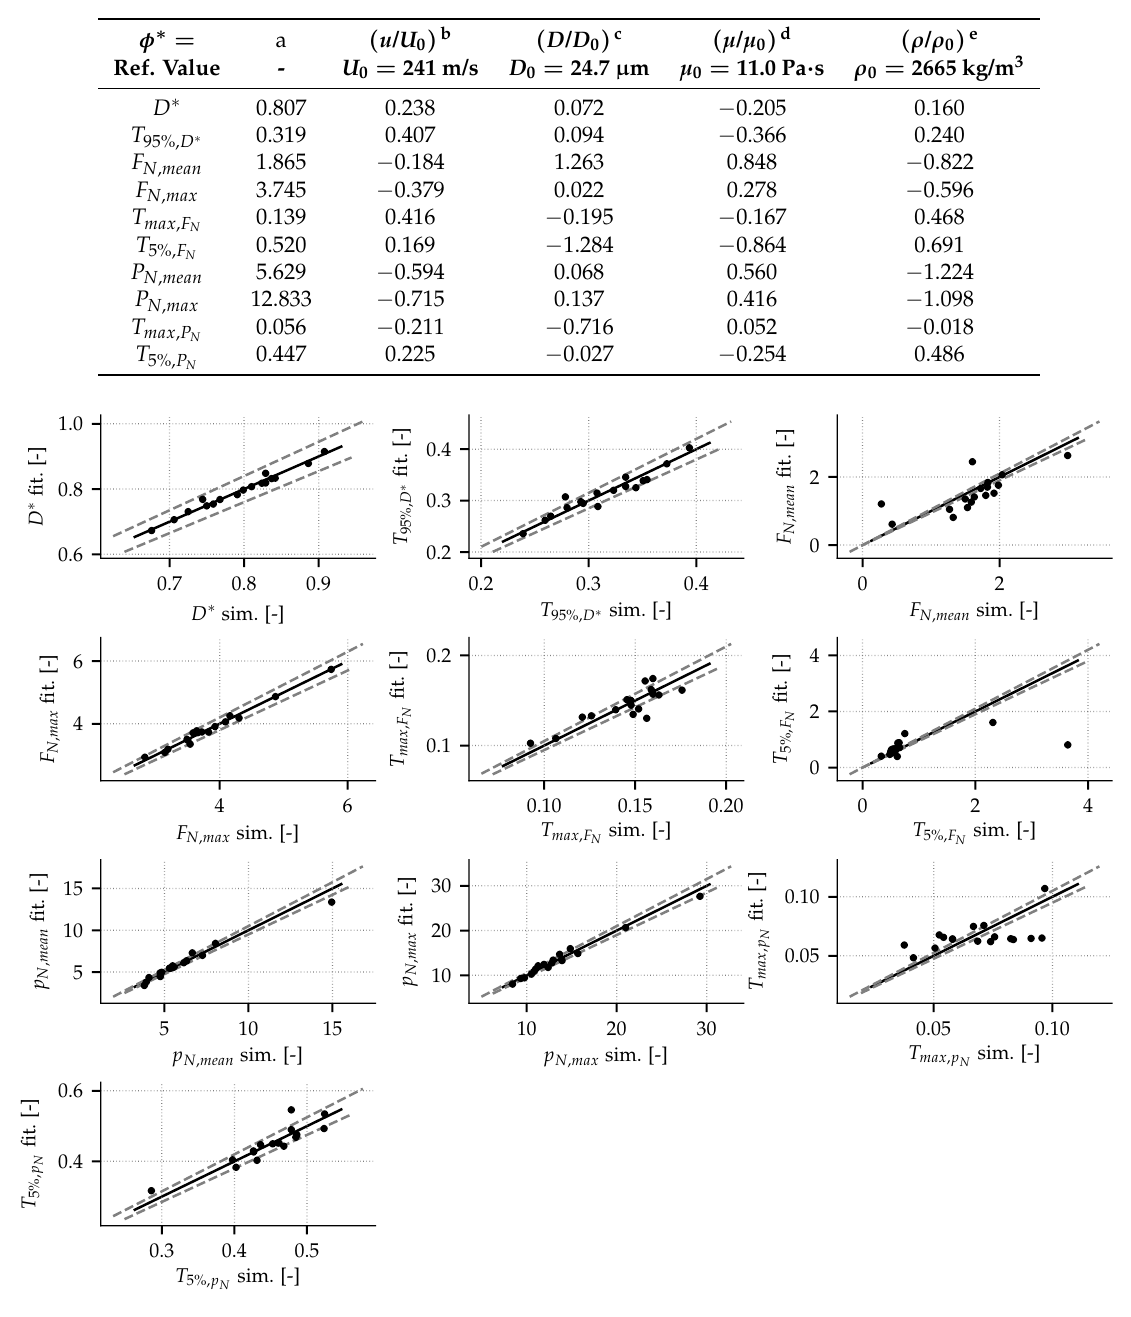
Table 4. Correlations on peak values. Variables a to e refer to those in Equation (18). Reference values are expressed in SI units in the formulae.